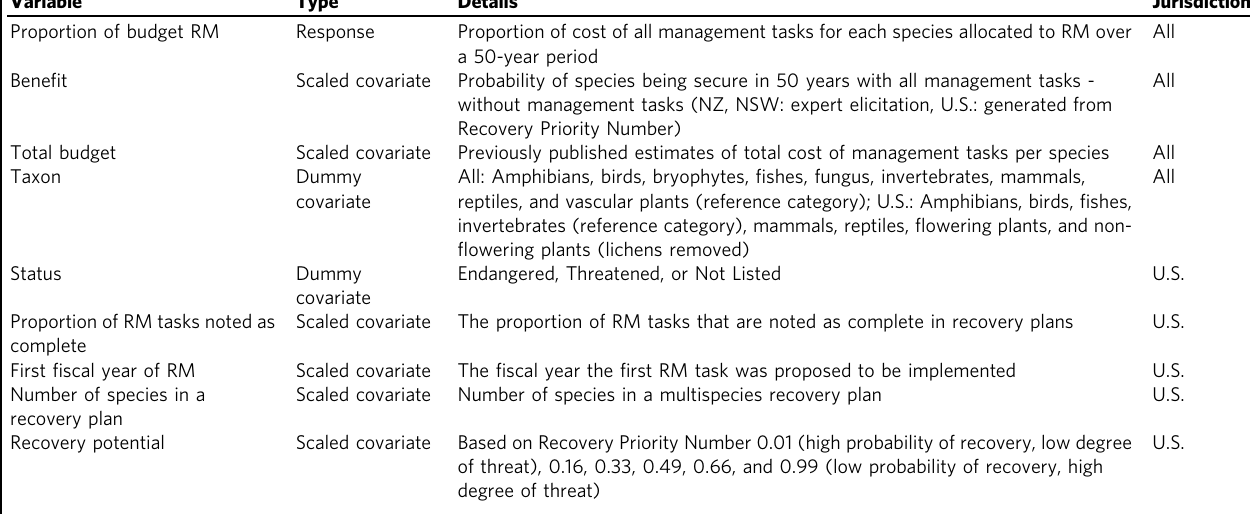
Fig. 2 Proportion of the budget allocated to research and monitoring for threatened taxa. The median and range of proportion of recovery plan budgets allocated to research and monitoring (RM) for n = 2261 threatened species in a variety of taxa in the United States (U.S.), New Zealand (NZ), and New South Wales, Australia (NSW). For each taxon, the box and whiskers show the median as a line, fi rst and third quartiles as hinges, and the highest and lowest values within 1.5 times the inter-quartile range as whiskers. Maps were created in ArcGIS for Desktop (10.3, ESRI Inc., USA). Table 1 Covariates used to examine the drivers of proportion of threatened species budget allocated to research and monitoring (RM; in three jurisdictions: New Zealand, NZ, New South Wales, Australia, NSW, and the United States, U.S.). Variable